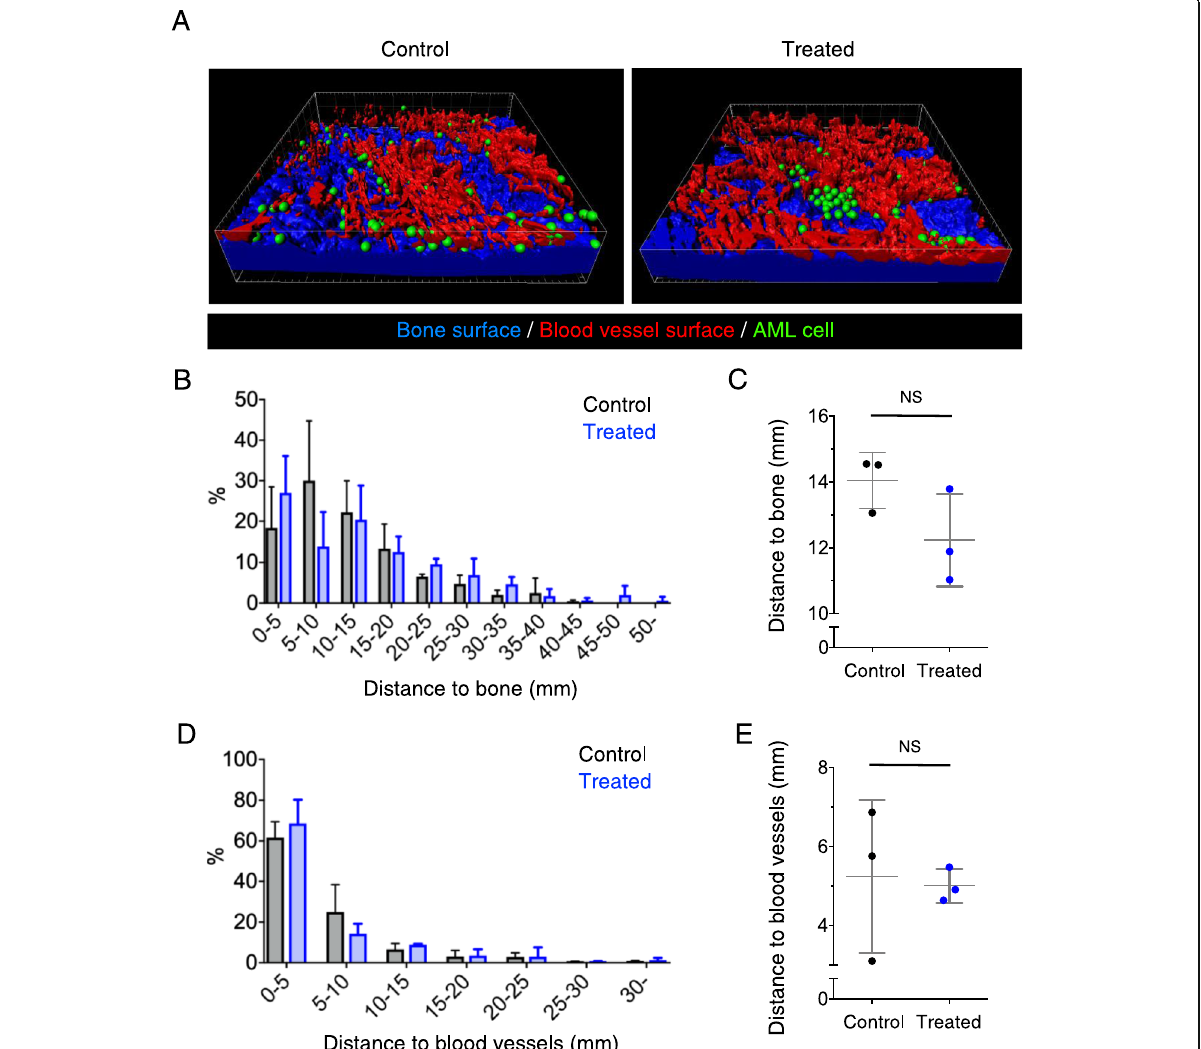
Fig. 2 Localization of chemoresistant AML cells in the bone. a Representative intravital two-photon 3D skull images of AML control mice and AML mice treated with chemotherapy. Green spots, AML cells; red, surface of blood vessels; blue, surface of bone tissues. See also Video 2. b , d Distribution of distance between AML cells and the bone surface ( b ) or blood vessels ( d ). Pooled data from three mice per group are shown. Control, n = 400; treated, n = 235. c , e Mean distance between AML cells and the bone surface ( c ) or blood vessels ( e ). NS, not